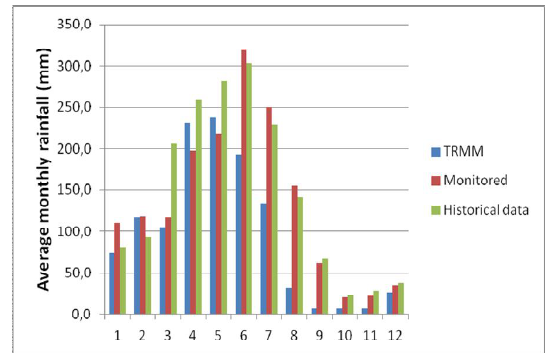
Figure 11. Average monthly rainfall (TRMM, Monitored and historical data)